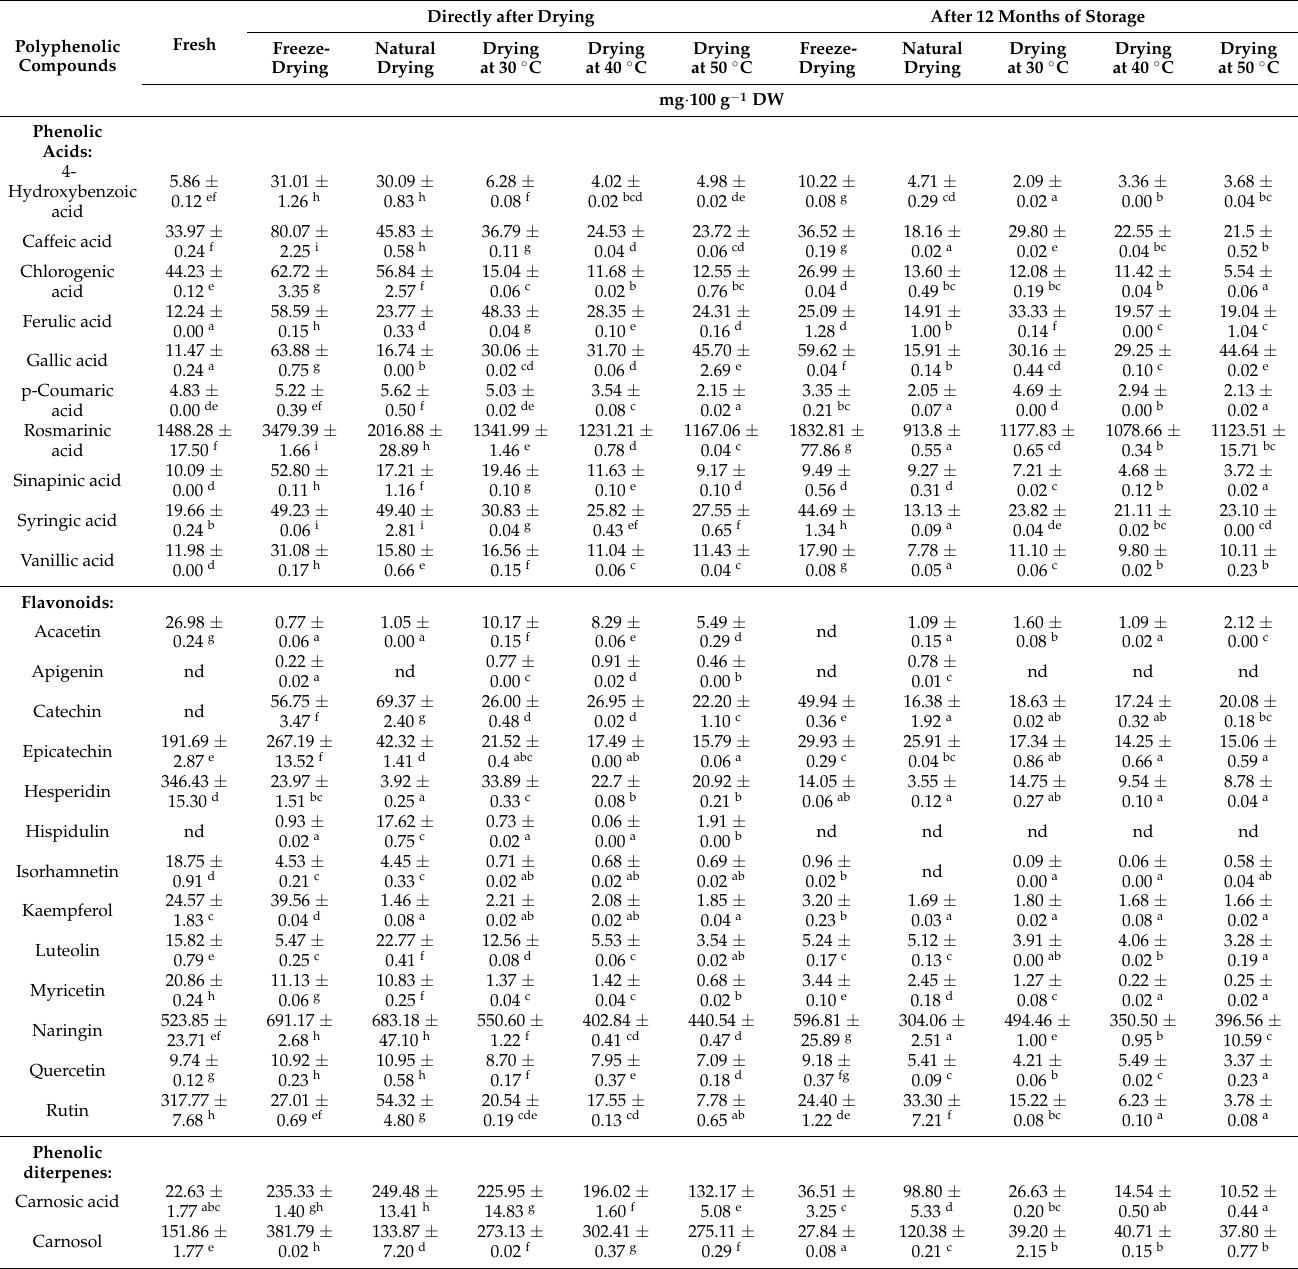
Table 6. Concentration of individual polyphenolic compounds in fresh, dried, and stored Salvia officinalis